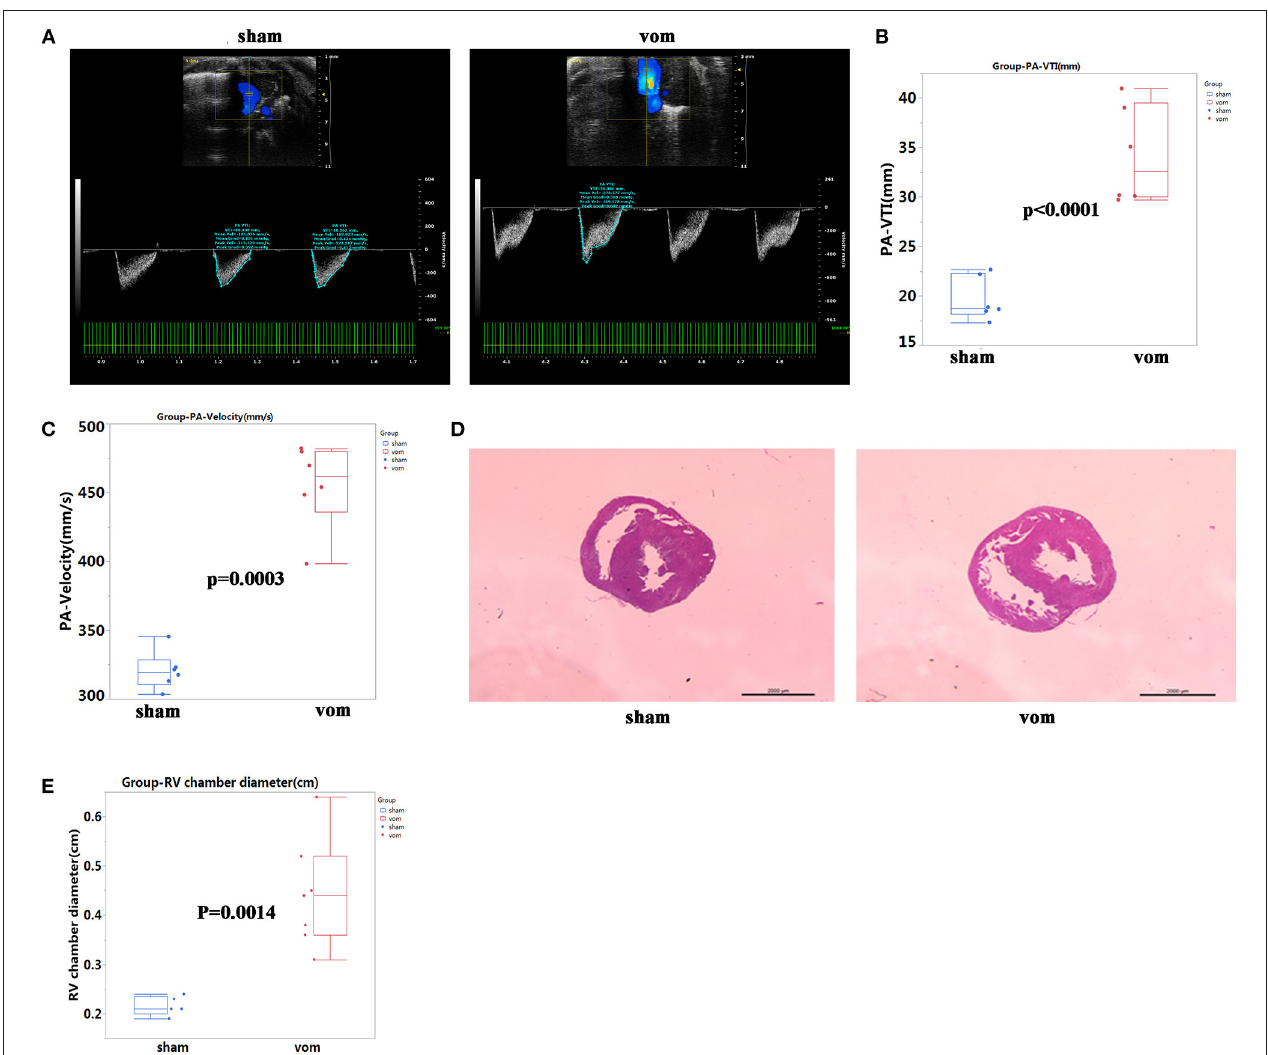
FIGURE 2 | Verification of VO in the AVF group. (A) Representative echocardiogram of pulmonary artery (PA) velocity time integral (VTI) and velocity in the sham and VO model (vom) groups. (B) Quantification of PA- VTI in the sham and vom groups, N = 6. (C) Quantification of PA-velocity in the sham and vom groups, N = 6. (D) Middle panel, representative H&E staining of hearts from the sham and vom groups. (E) Middle panel, quantification of the diameter of the RV